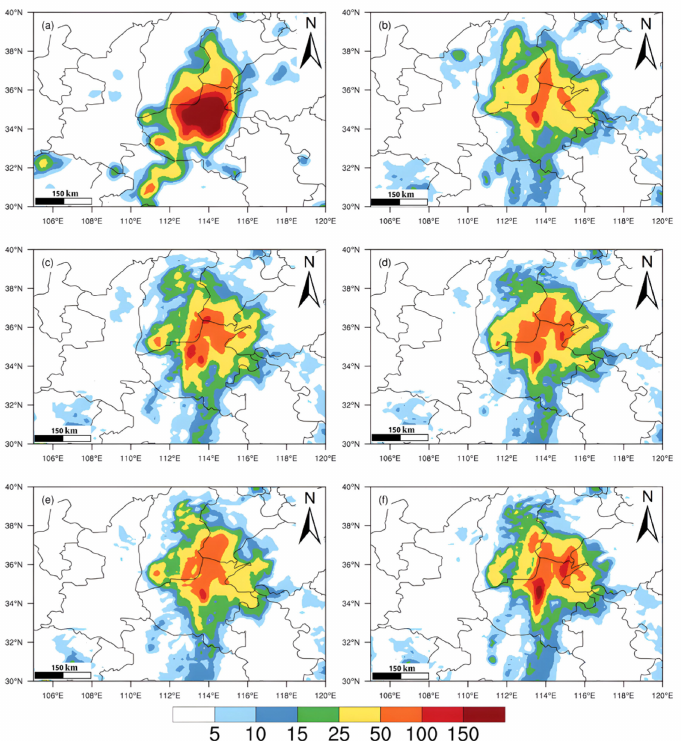
Figure 9. The 24 h cumulative rainfall (unit: mm) from 00:00 to 23:00 on 20 July with a model start time of 00:00 on the 19th: ( a ) measured rainfall, ( b ) exp0, ( c ) exp1, ( d ) exp2, ( e ) exp3, and ( f )